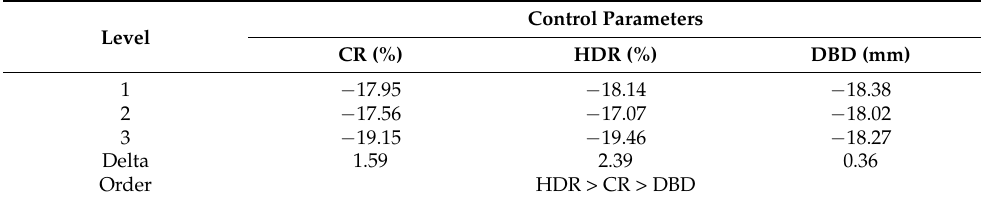
Table 5. Signal-to-noise response table for drag force. Level